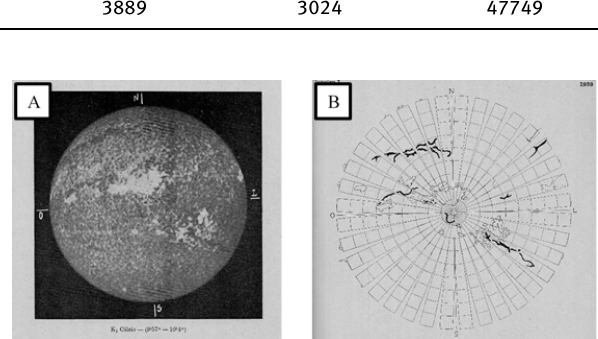
Figure 9. Ca K1 solar image acquired on January 1st, 1929 (A), and the planar transformation, of the same image, purposed by Costa Lobo to register the position of sunspots and facular regions (B) [Source: Lobo